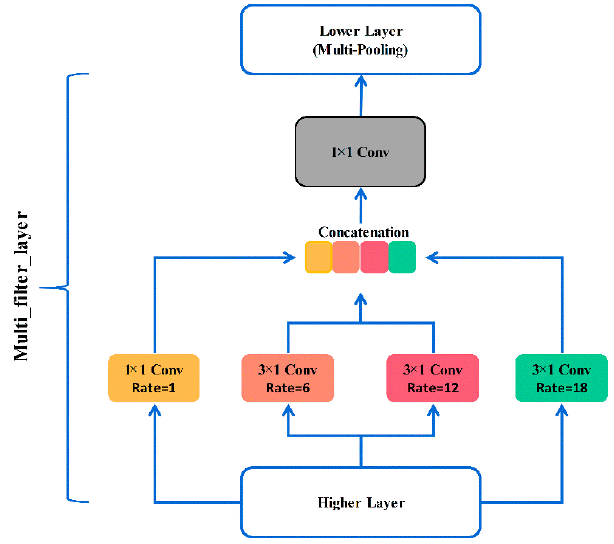
Figure 6. The structure of multi-scale feature extraction module.